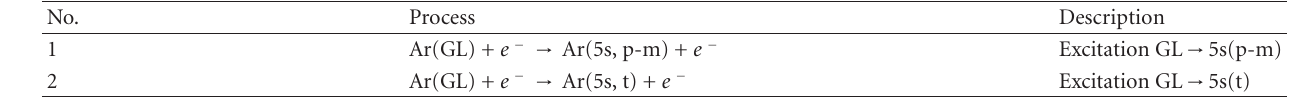
Table 4: Inelastic processes involving Ar I 5s species.